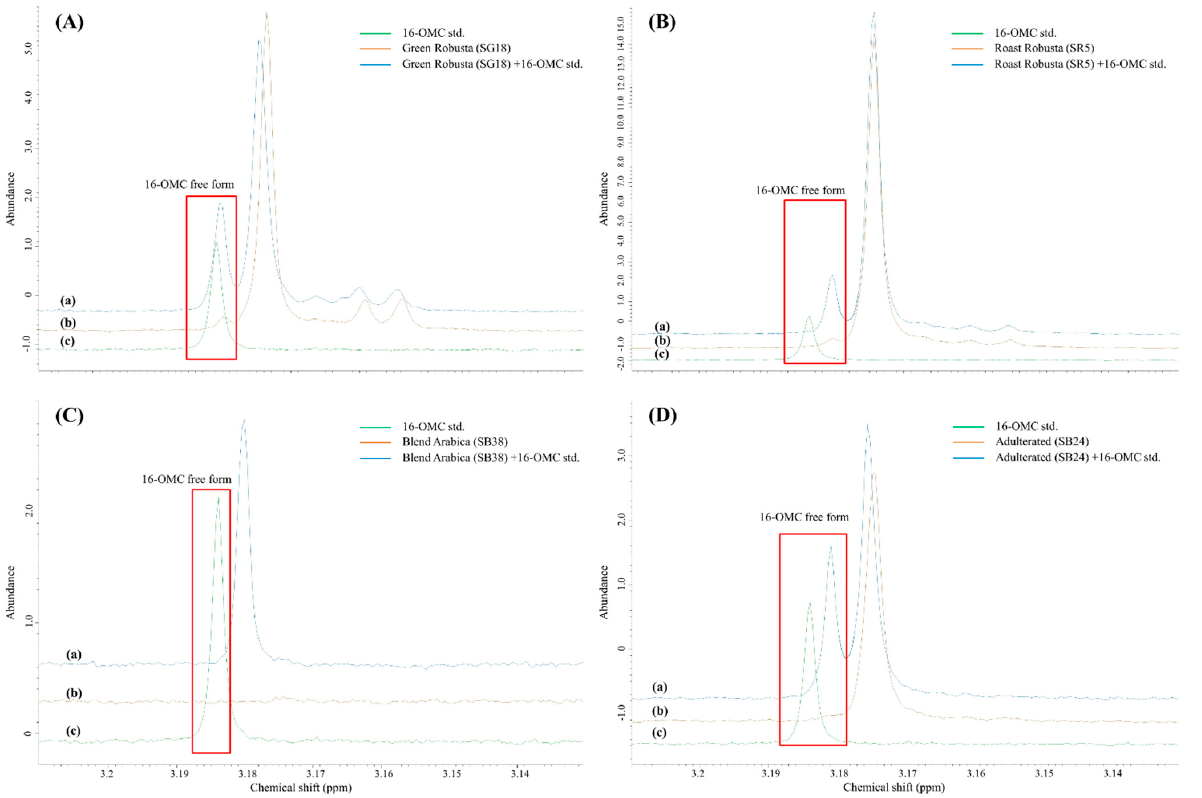
Figure 4. The overlap of samples with 16-OMC ( a ), coffee sample ( b ) and 16-OMC stand- ard ( c ) of green Robusta ( A ), roast Robusta ( B ), blend Arabica ( C ), and adulterated sample ( D ). The signals of free form 16-OMC are indicated.